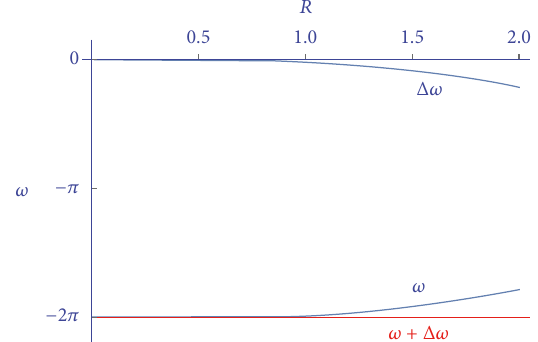
Figure 6: Contributions 𝜔(𝑅) and Δ𝜔(𝑅) to the determination of the rotational angle of the fibre neighbourhood.